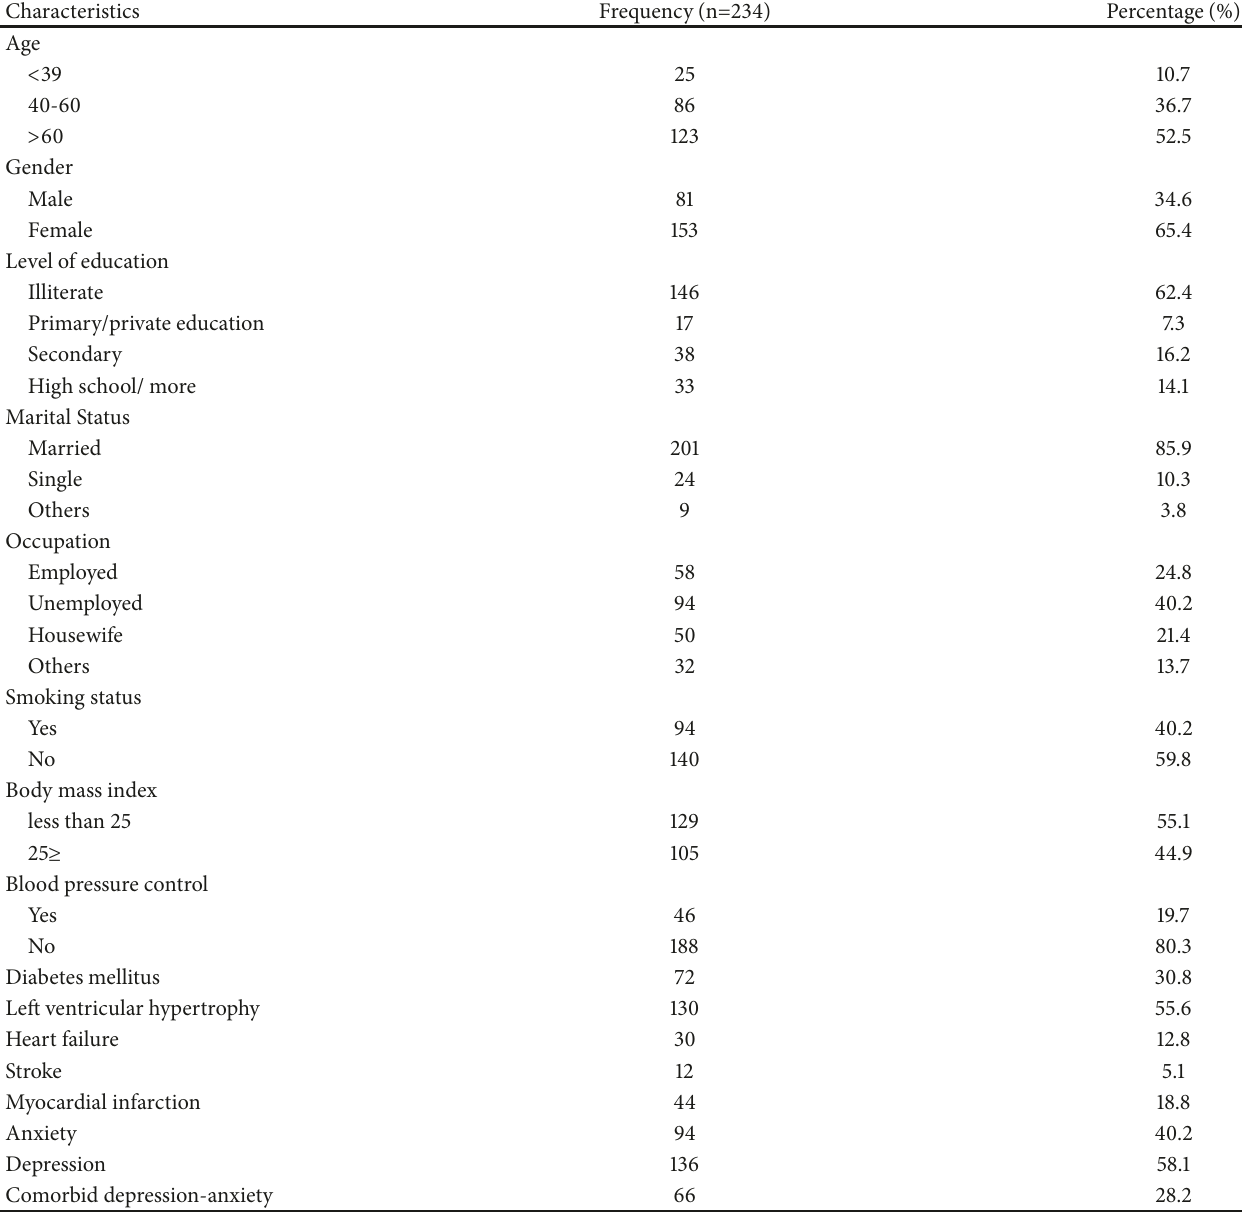
Table 1: Sociodemographic and clinical characteristics of study